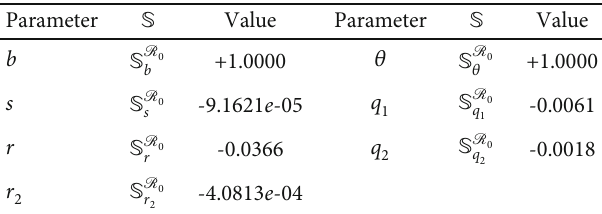
Table 1: Sensitivity of the R 0 versus proposed